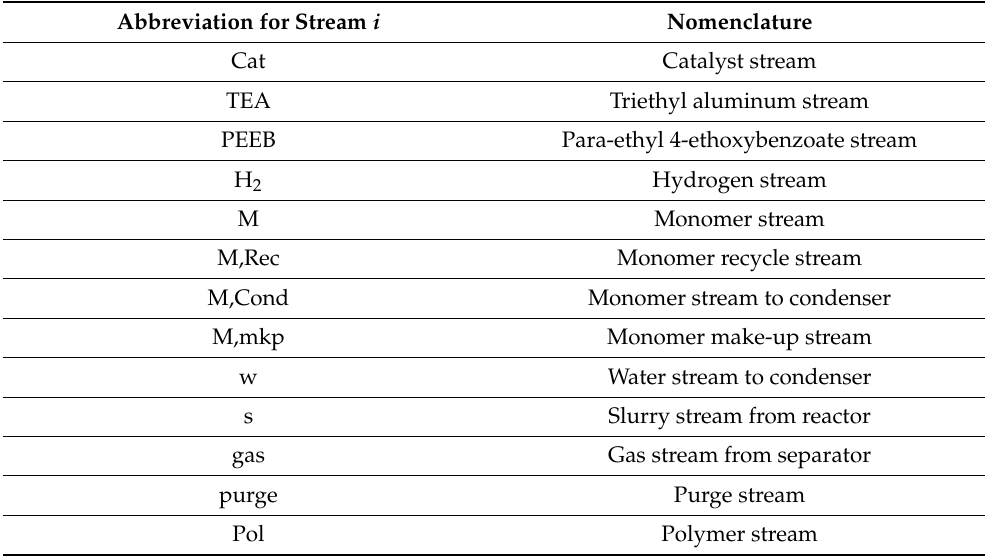
Table 3. Symbols and abbreviations used in Figure 6 for stream i .